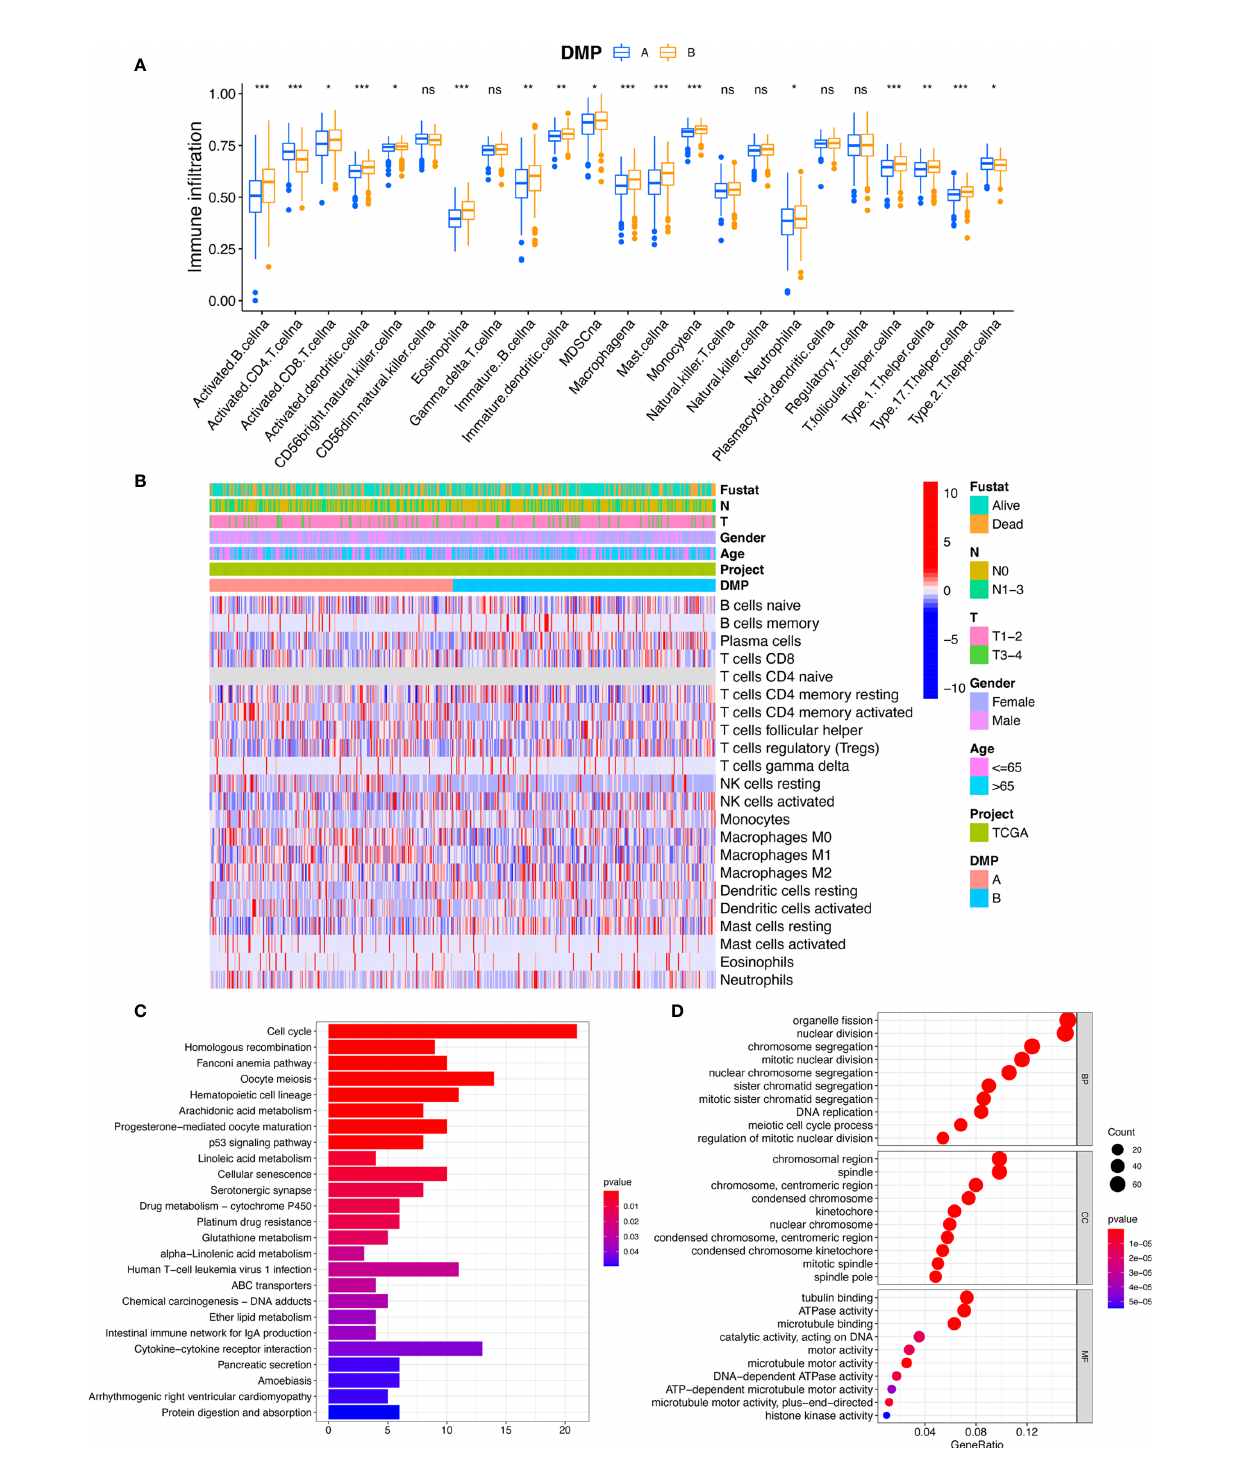
FIGURE 3 | TME characteristics and transcriptome traits of DNA methylation modi fi cation patterns. (A) The abundance of immune in fi ltration cells in two DMP clusters using ssGSVA algorithm. * p < 0.05, ** p < 0.01, *** p < 0.001. (B) The CIBERSORT heatmap of tumor immune-in fi ltrating cells in TCGA cohort. Clinical data regarding survival state, tumor stage, gender, age, and DMP cluster were annotated above. Red represents the higher fraction of immune cells in each sample; blue, the lower fraction. (C, D) Functional annotation for DMP-related genes using GO and KEGG enrichment analyses. The color depth of the KEGG barplots represents the enriched gene count. ns, no signi fi